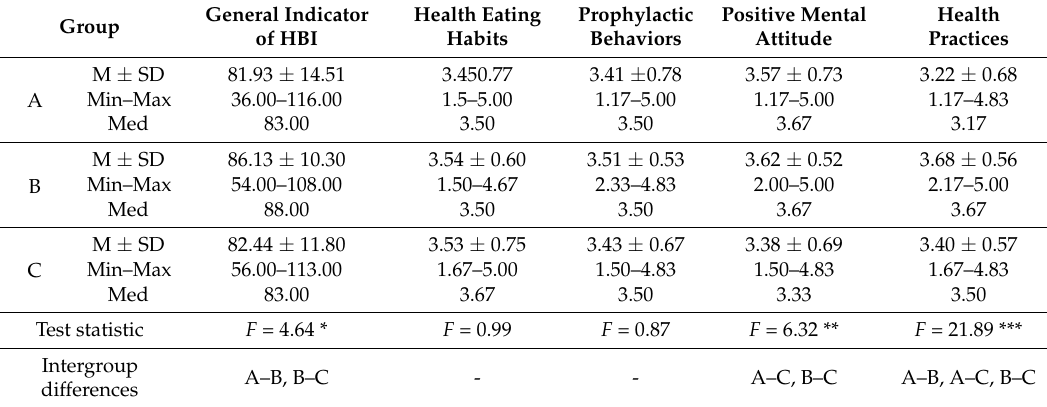
Table 2. Health behaviors in studied groups.